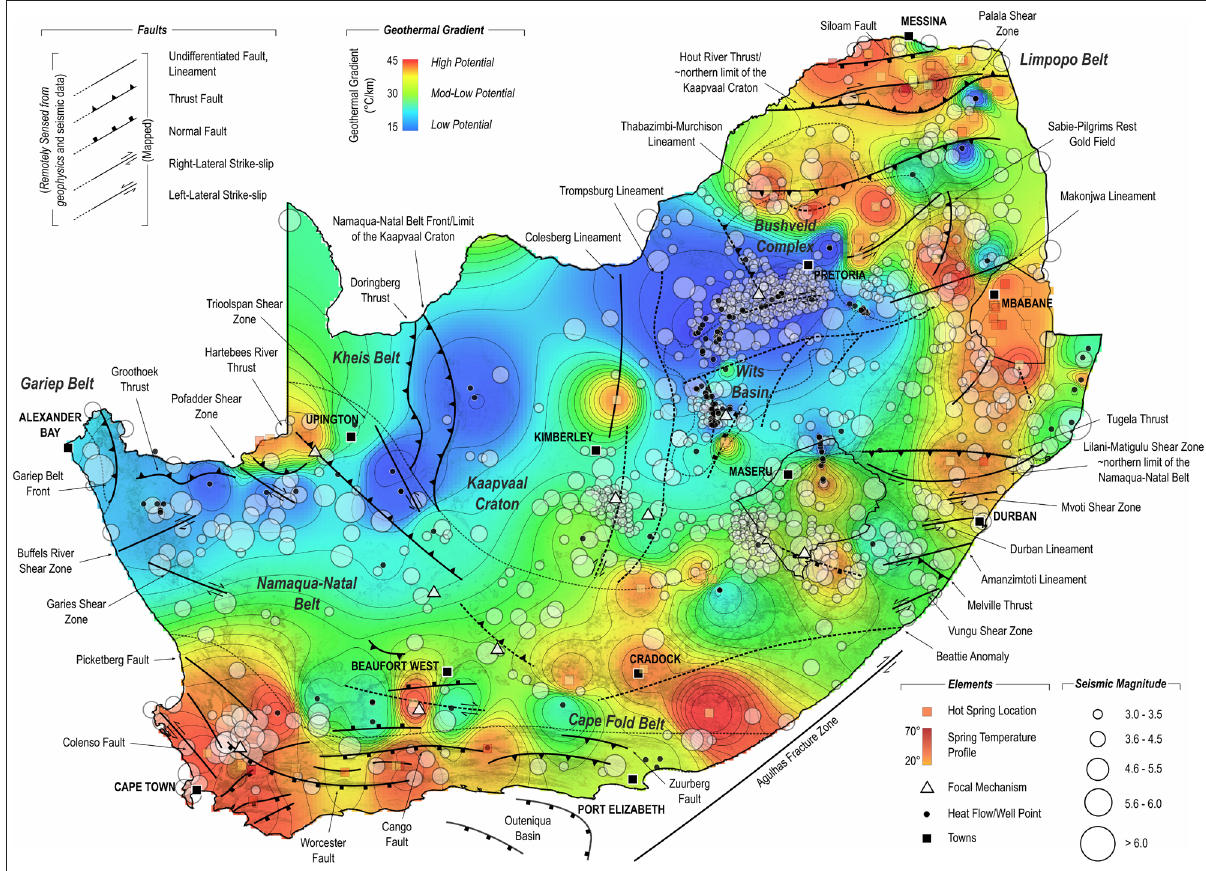
Graphical overview of the calculated geothermal gradients across South Africa. Map includes major tectonic contacts and structures, seismic activity and earthquake focal mechanisms and hot spring